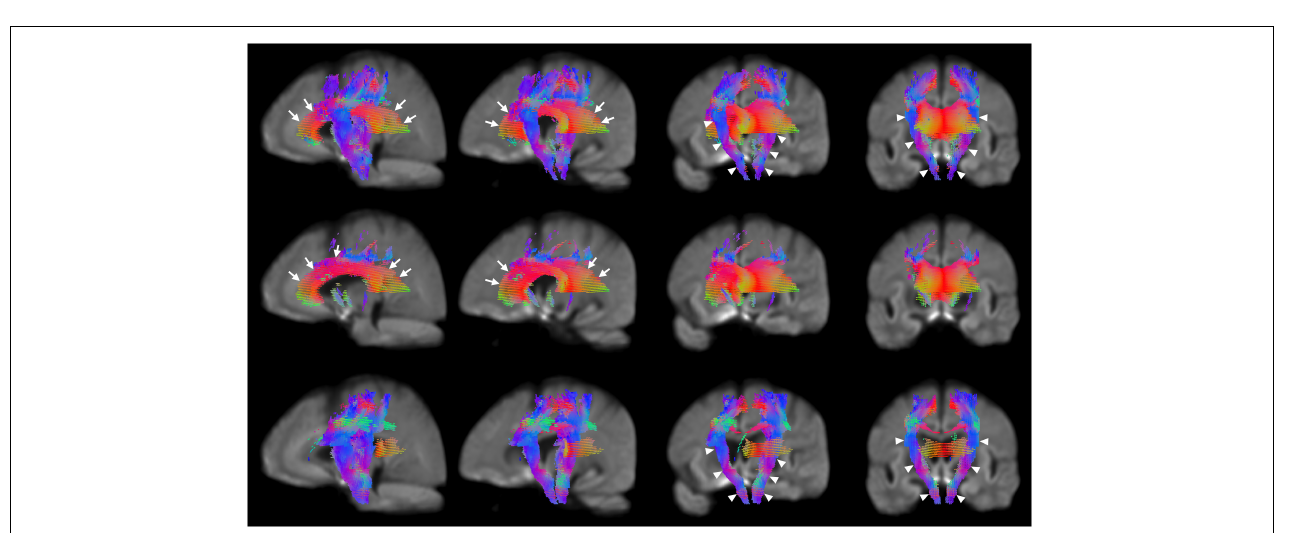
FIGURE 3 | Areas of significant reductions in FDC, FD, and FC in patients with HD compared to healthy control participants, displayed as a rotation from sagittal to coronal views. Significant fixels (family-wise error corrected p < 0.05) were illustrated and colored according to fiber direction. The corpus callosum (seen in the leftmost and second columns) and internal capsule (seen in the third and rightmost columns) were labeled using white arrows. Top row: FDC reductions in corticospinal tract of patients with HD compared to healthy controls with rotation from sagittal to coronal views; second row: FD reductions in corticospinal tract of patients with HD compared to healthy controls with rotation from sagittal to coronal views; bottom row; FC reductions in corticospinal tract of patients with HD compared to healthy controls with rotation from sagittal to coronal